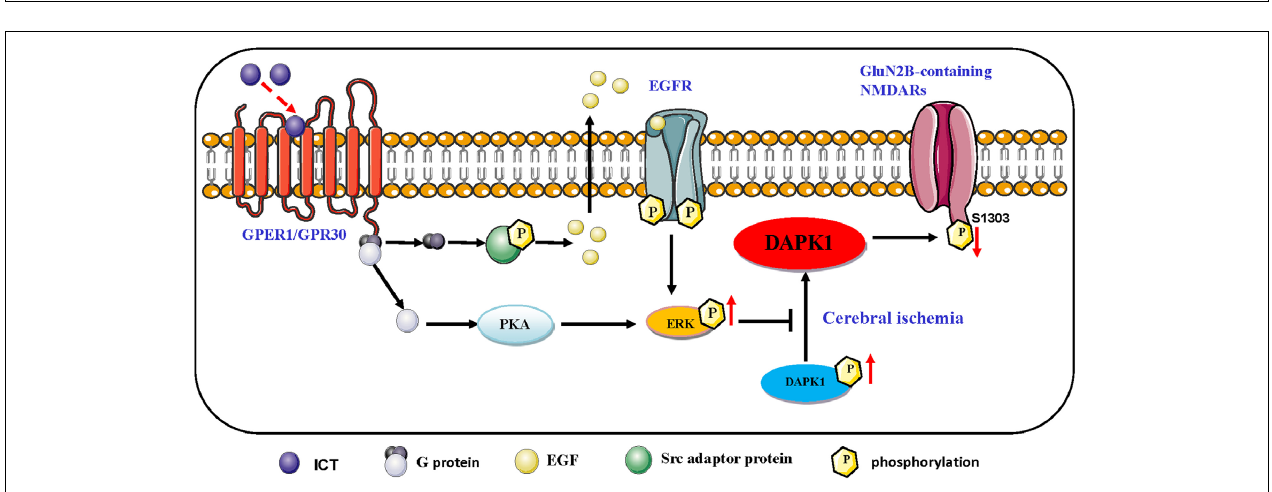
FIGURE 7 | Schematic representation of the proposed resisting the excitability toxicity signaling pathways triggered by ICT in ischemic neurons. ICT activates GPR30-ERK pathways, and phosphorylated ERK up-regulate the phosphorylated DAPK1, which prevent the phosphorylation of GluN2B and the activation of GluN2B-containing